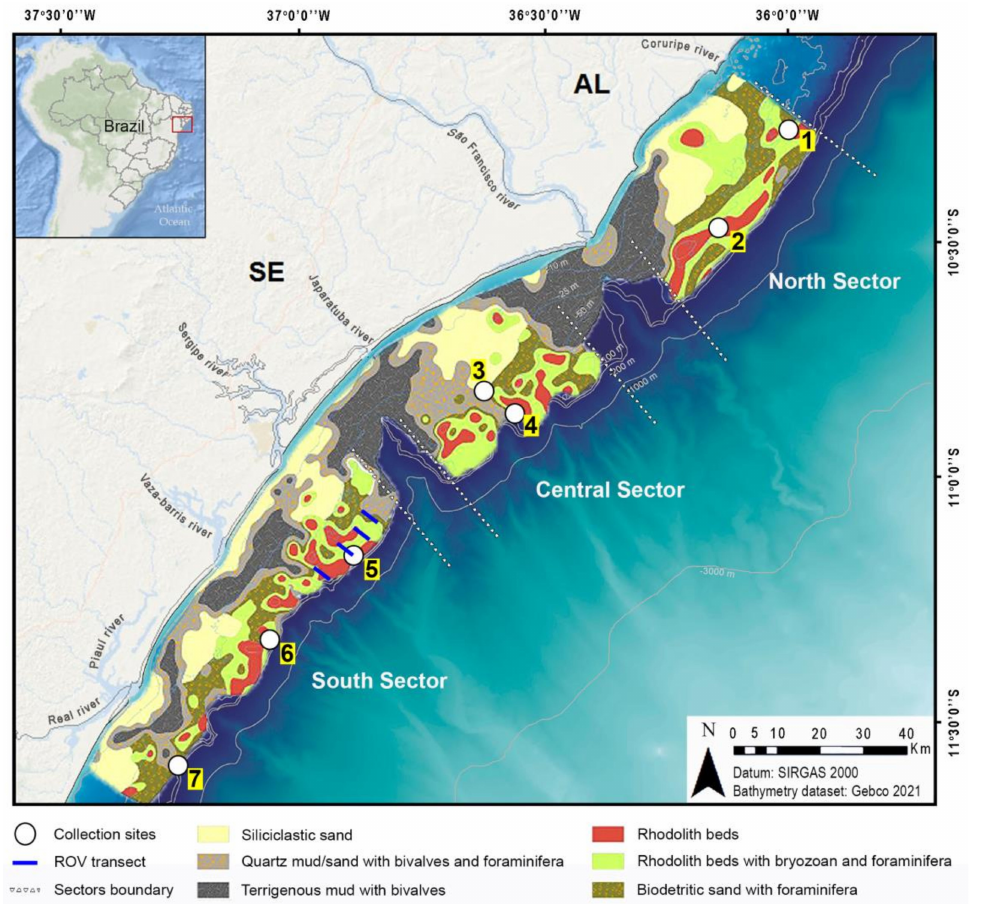
Figure 1. Sergipe-Alagoas (SEAL) Basin and collection sites (white circles with numbers 1–7) along the three carbonate domain sectors (North, Central and South) on the middle/outer shelf collected in 2011 and transects surveyed by a remotely operated vehicle (ROV) from the south sector obtained in 2014 (blue lines) with biofacies data [21] and the bathymetry dataset [22]. The tidal regime in the study area is semi-diurnal, with amplitude between 1.0